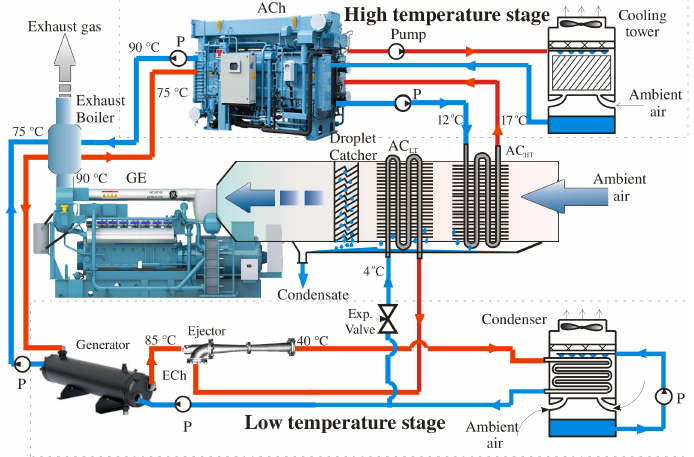
Figure 9. A two-stage absorption-ejector (AECh) system for chilling engine inlet air: AC HT and AC LT —high- and low-temperature air coolers;